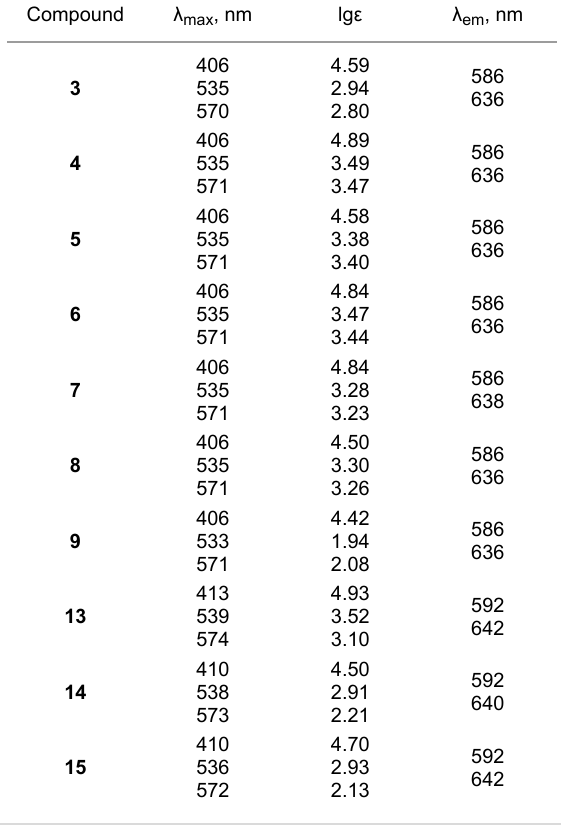
Table 4: UV–vis and fluorescence spectra of the arylated porphyrins 3–9 , 13–15 (in CH 2 Cl 2 ).